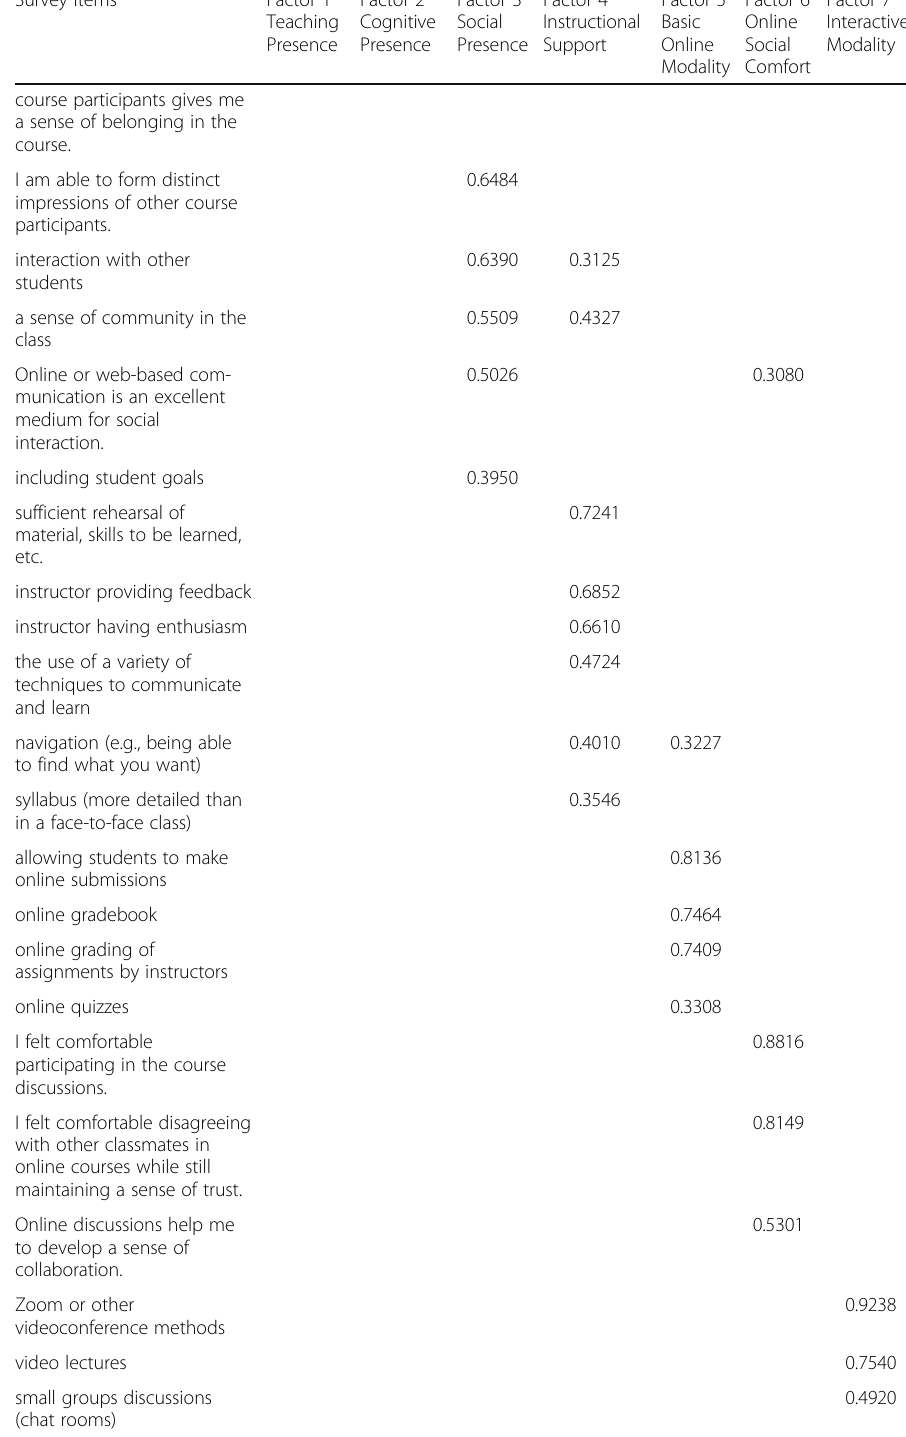
Table 2 Critical Success Factor Loading a